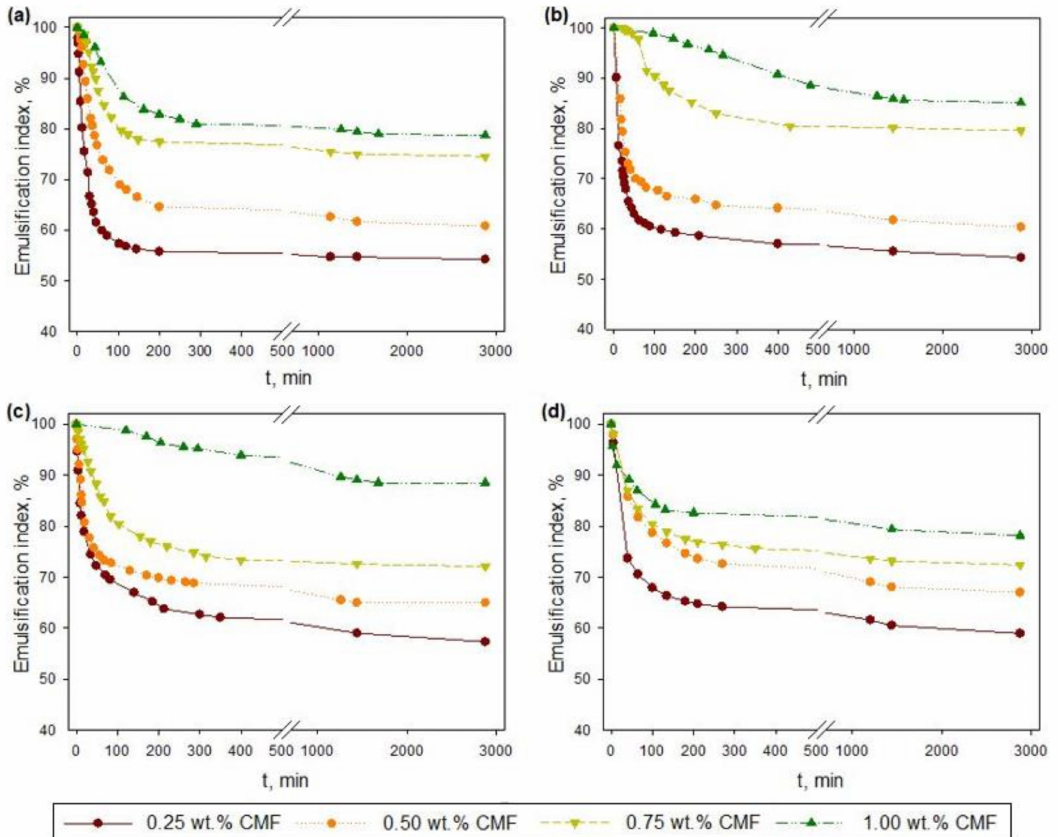
Figure 2. Effect of CMF dose on the emulsification index for sunflower oil-in-water (O/W) emulsions: ( a ) 40/60, ( b ) 50/50, ( c ) 60/40, and ( d )